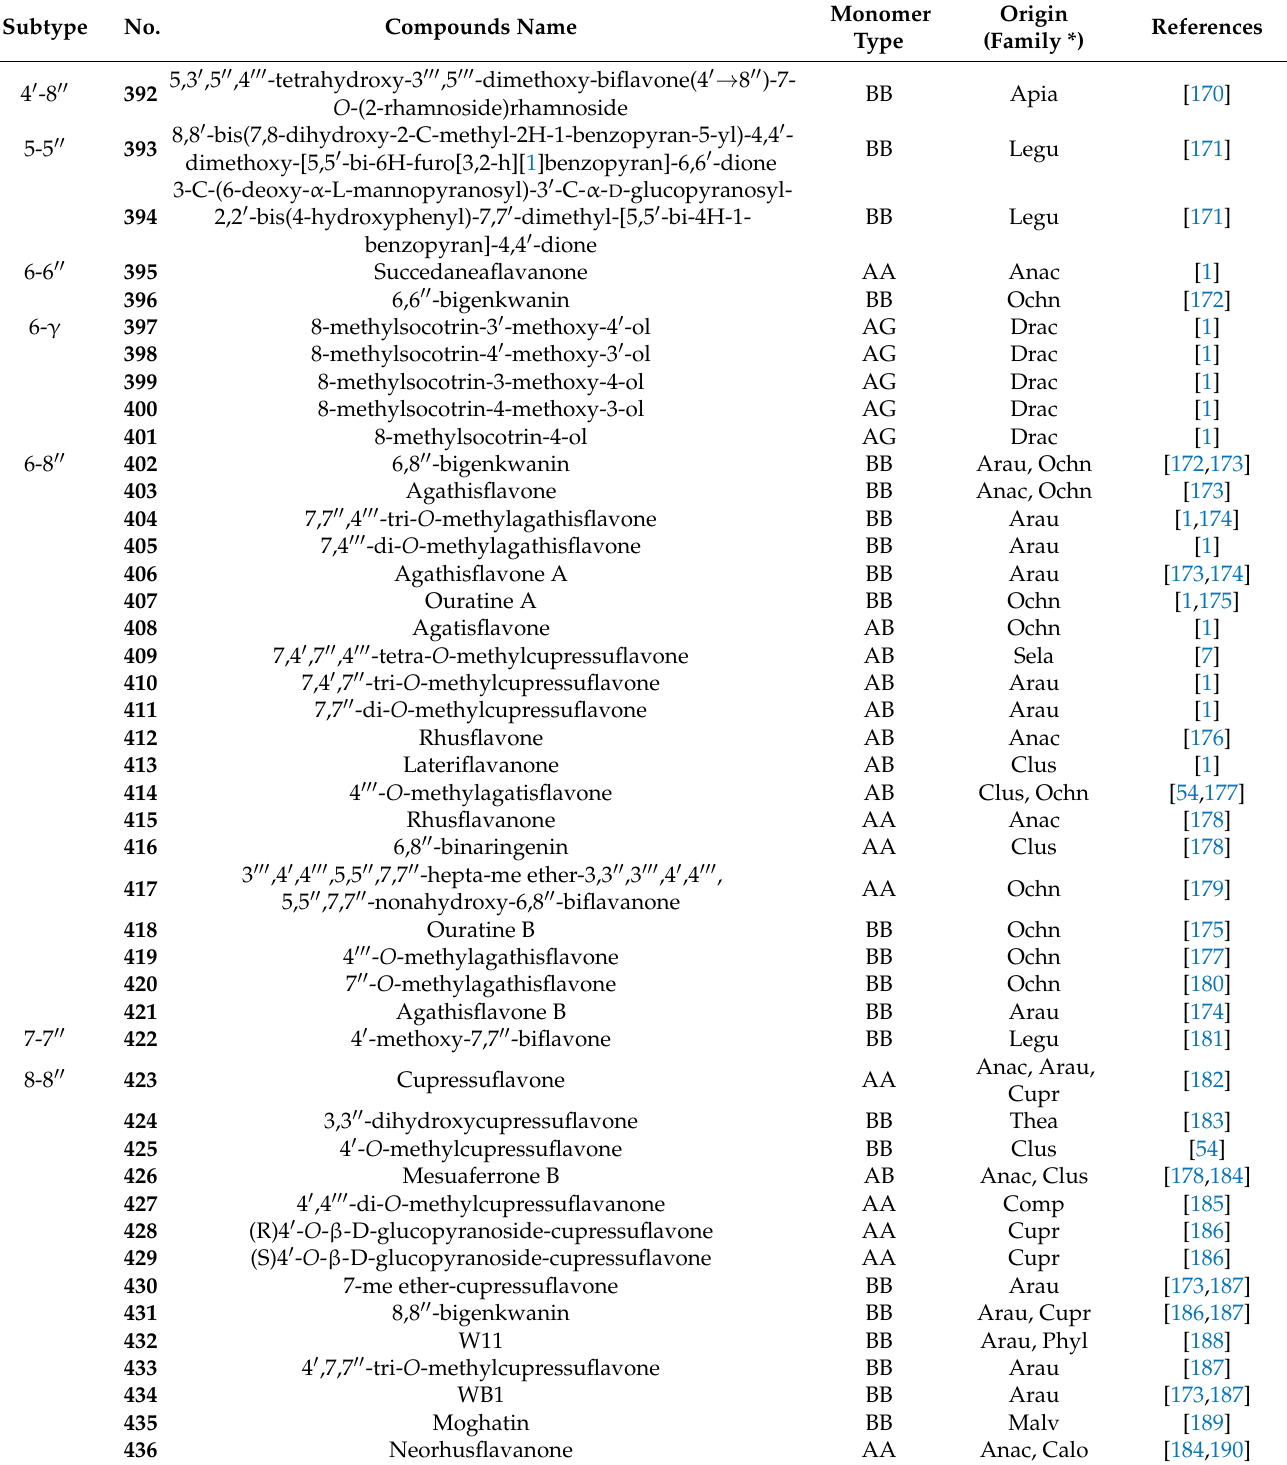
Table 8. The 4 (cid:48) -8 (cid:48)(cid:48) , 5-5 (cid:48)(cid:48) , 6-6 (cid:48)(cid:48) , 6- γ , 6-8 (cid:48)(cid:48) , 7-7 (cid:48)(cid:48) , and 8-8 (cid:48)(cid:48) subtypes of